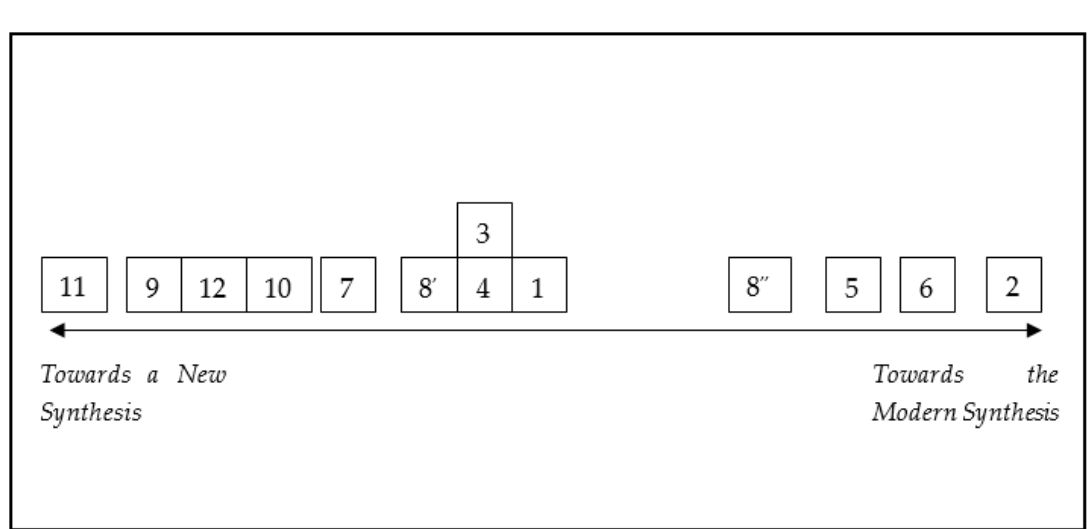
Figure 1. Theoretical Continuum of the various EvoDevo perspectives.